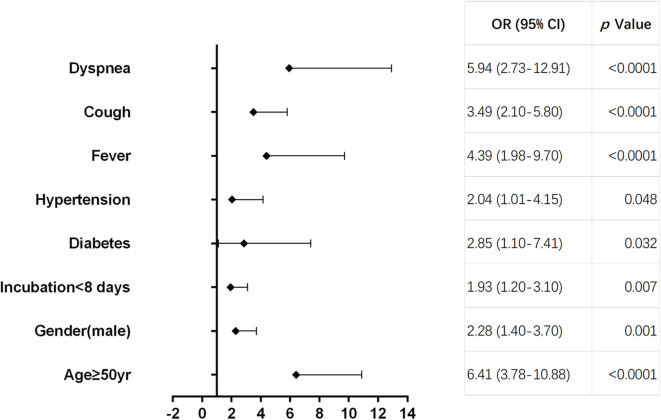
Forest plot of pre-hospital factors. Forest plot displaying the odds ratio (OR) and 95% confidence interval (95% CI) of each pre-hospital factor for deterioration in moderate cases.